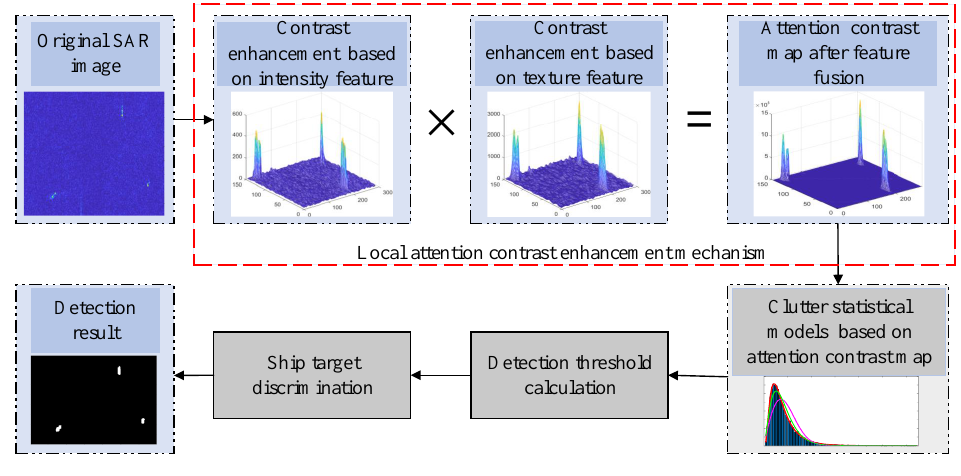
Figure 1. Flow chart of the proposed method.